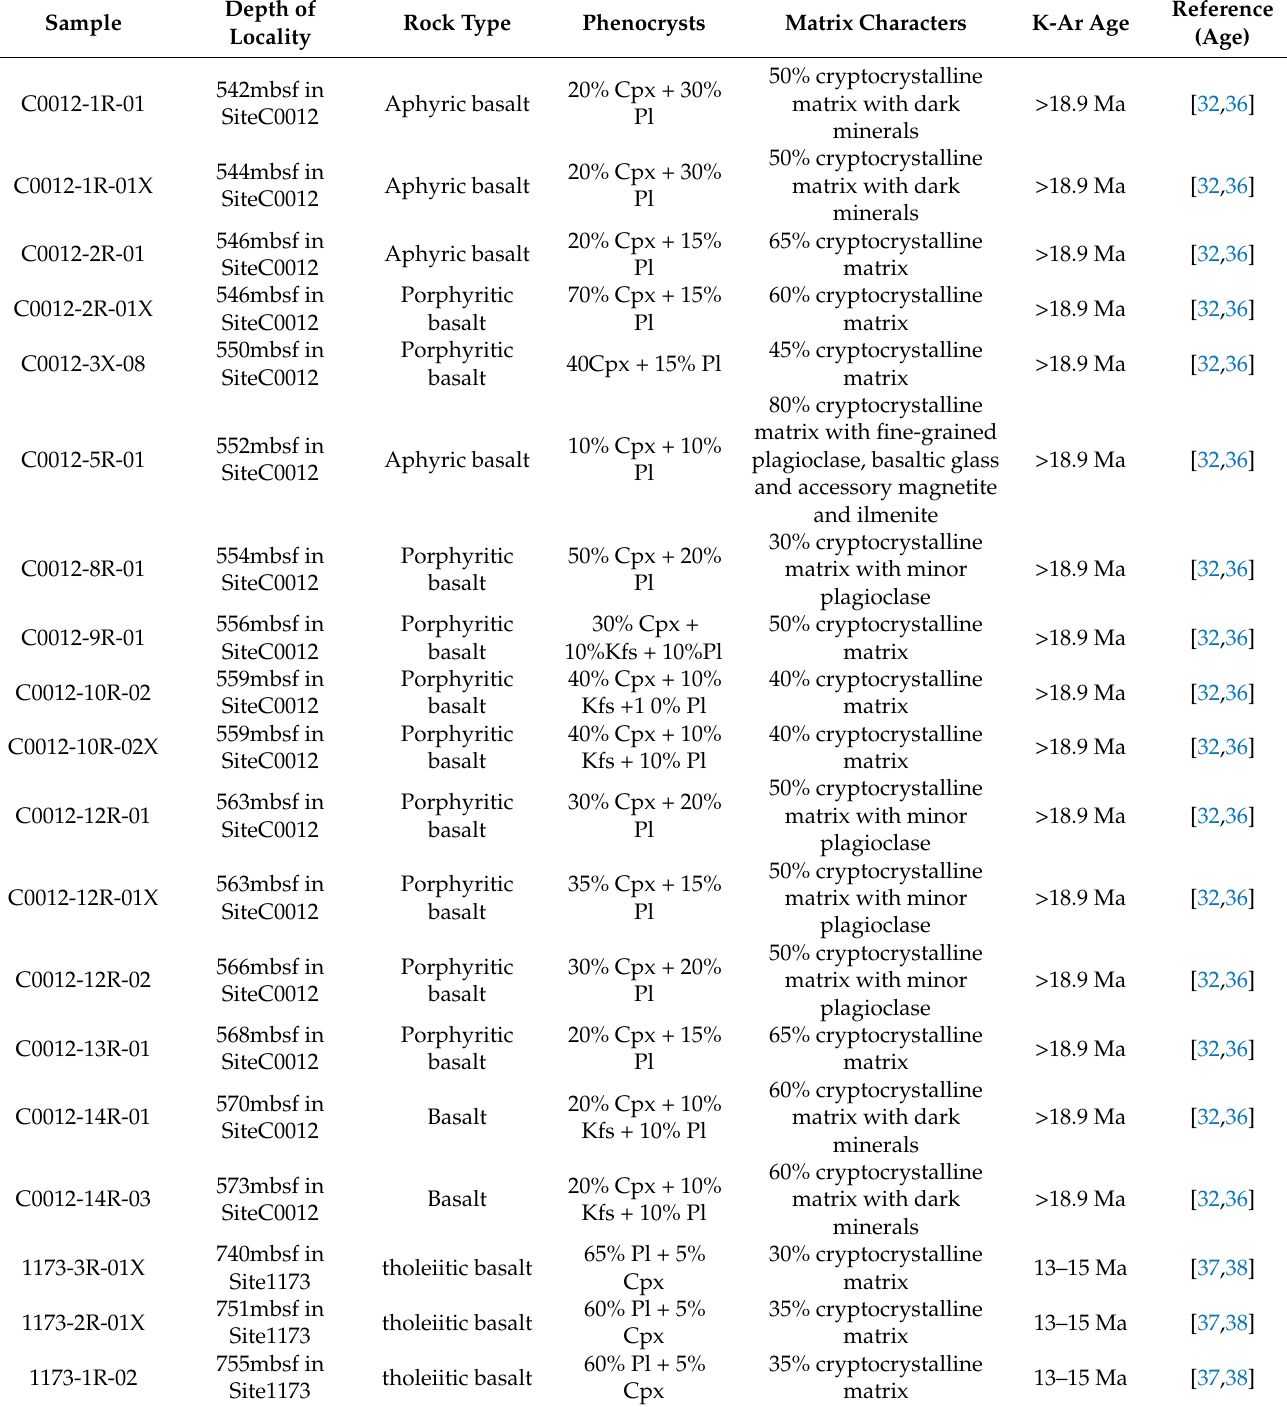
Table 4. Petrological description of Site C0012 and Site 1173 volcanic rocks from the Shikoku